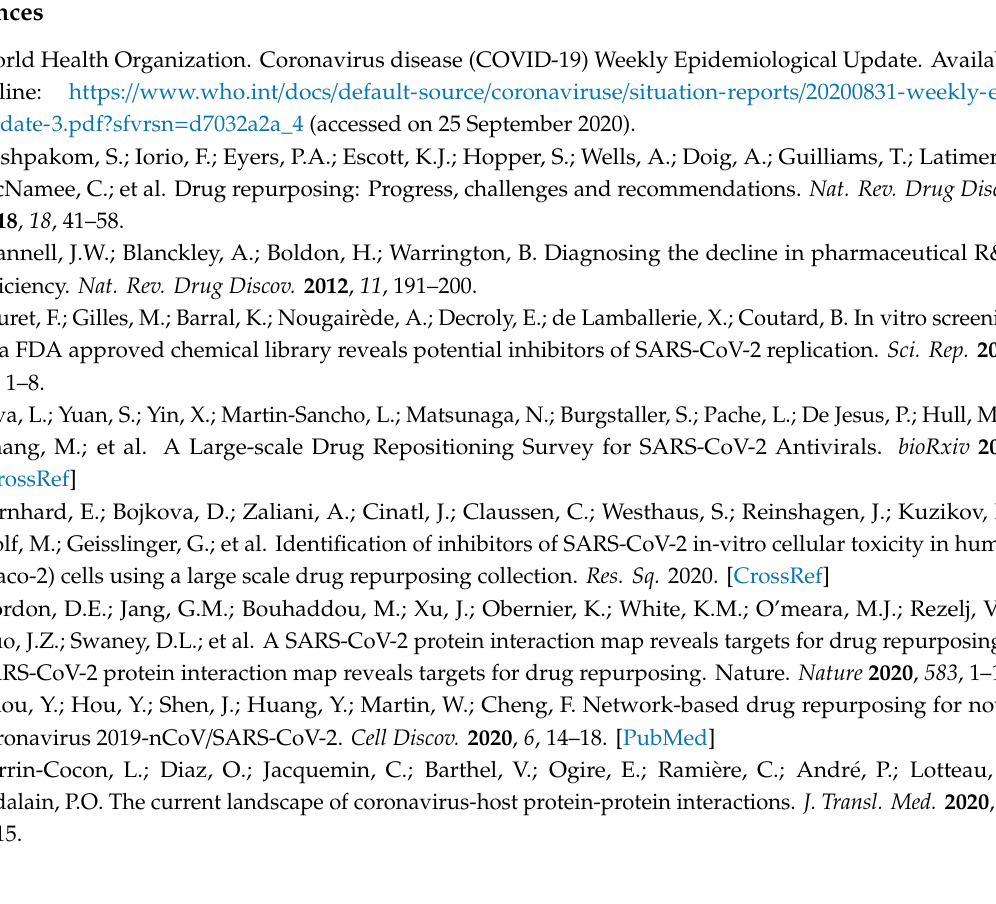
Table S1: Compounds targeting controllability-identified